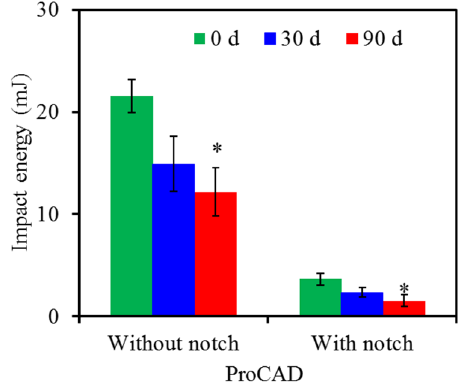
Figure 3. Impact energy of ProCAD without and with notch before and after soaking in pH 7 artificial saliva. Asterisk statistically significant difference ( p < 0.05) from the control group without soaking.